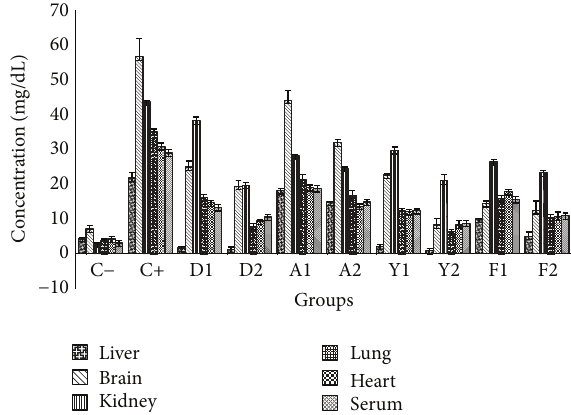
Figure 4: Effects of the extracts of yolk, albumen, and feed on low density lipoprotein profiles in liver, brain, kidney, lung, heart, and serum (mg/dL). Each value represents mean ( 𝑛 = 5 ).